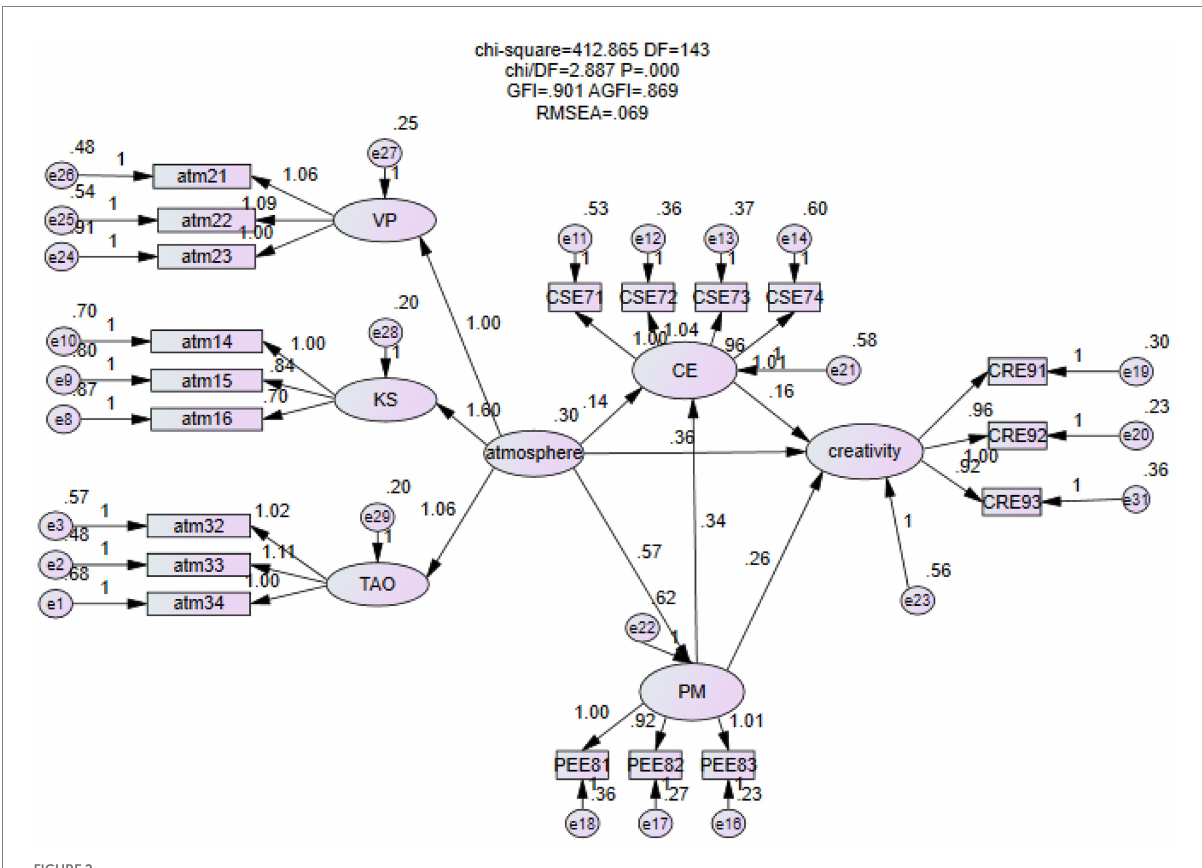
FIGURE 2 Structural equation model